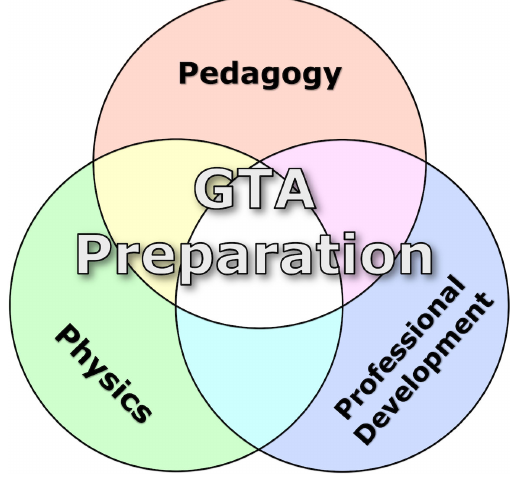
FIG. 2. Illustration of the 3P framework, and how the integra- tion of pedagogy, physics, and professional development leads to a comprehensive GTA preparation